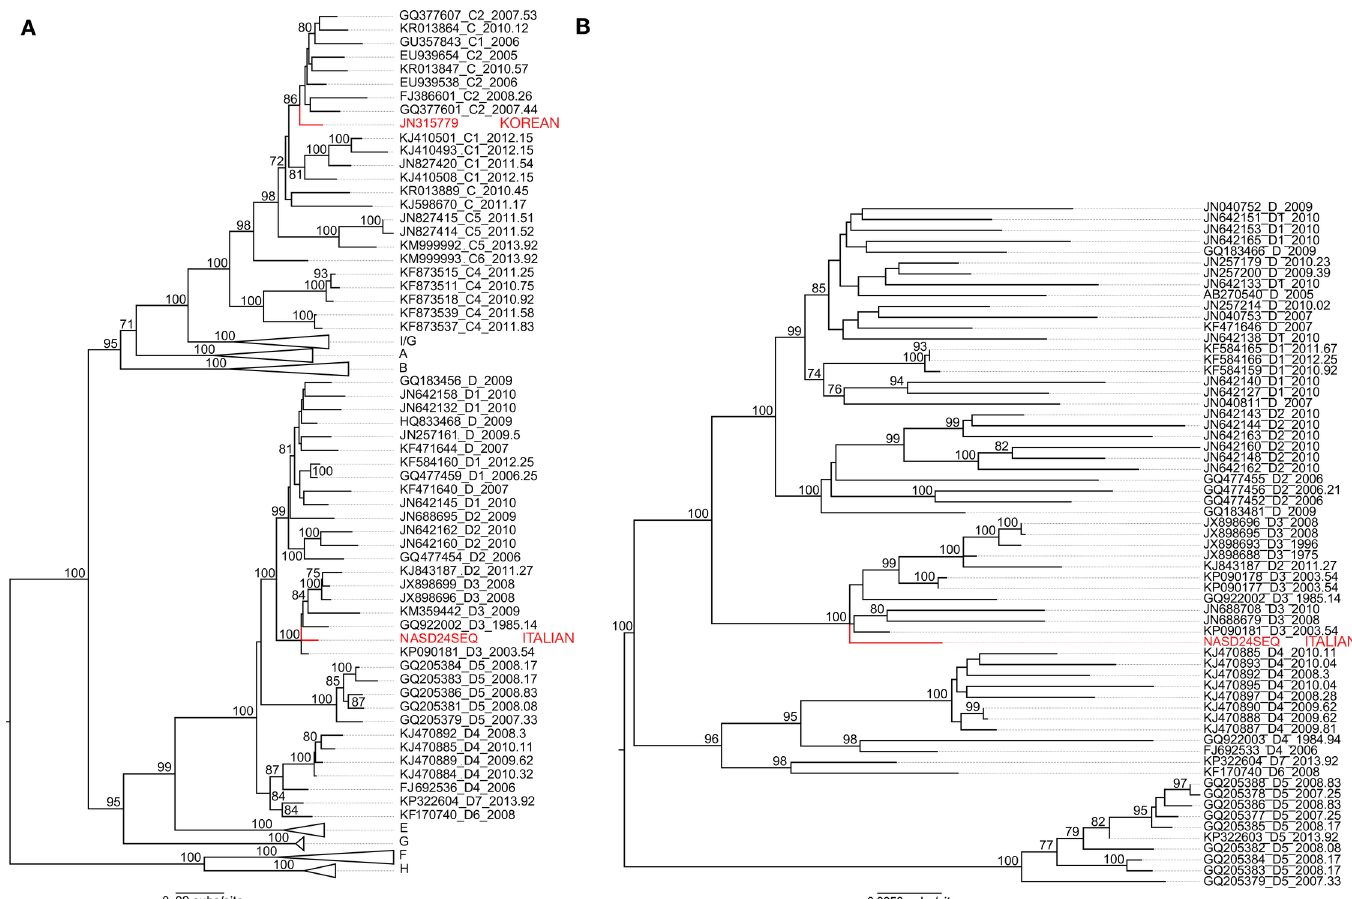
Fig 4. Phylogenetic analysis of ancient and modern HBV sequences. Tip labels on the phylogenies includethe GenBank accession number followedby genotypeand subgenotype information and year of sampling(day and month information is encodedinto decimalform). NASD24SEQ and JN315779are colored in red. Nodes receivingbootstrap support above 70% are displayed.All horizontal branch lengthsare scaled accordingto the numberof nucleotide substitutionsper site and the tree is mid-point rooted for clarity only. (A) Shows the analysisof subset a-ii, includingthe modernHBV subset with both ancient sequences.(B) Shows the analysisof subset b-i, including only the modernD genotypesubset with